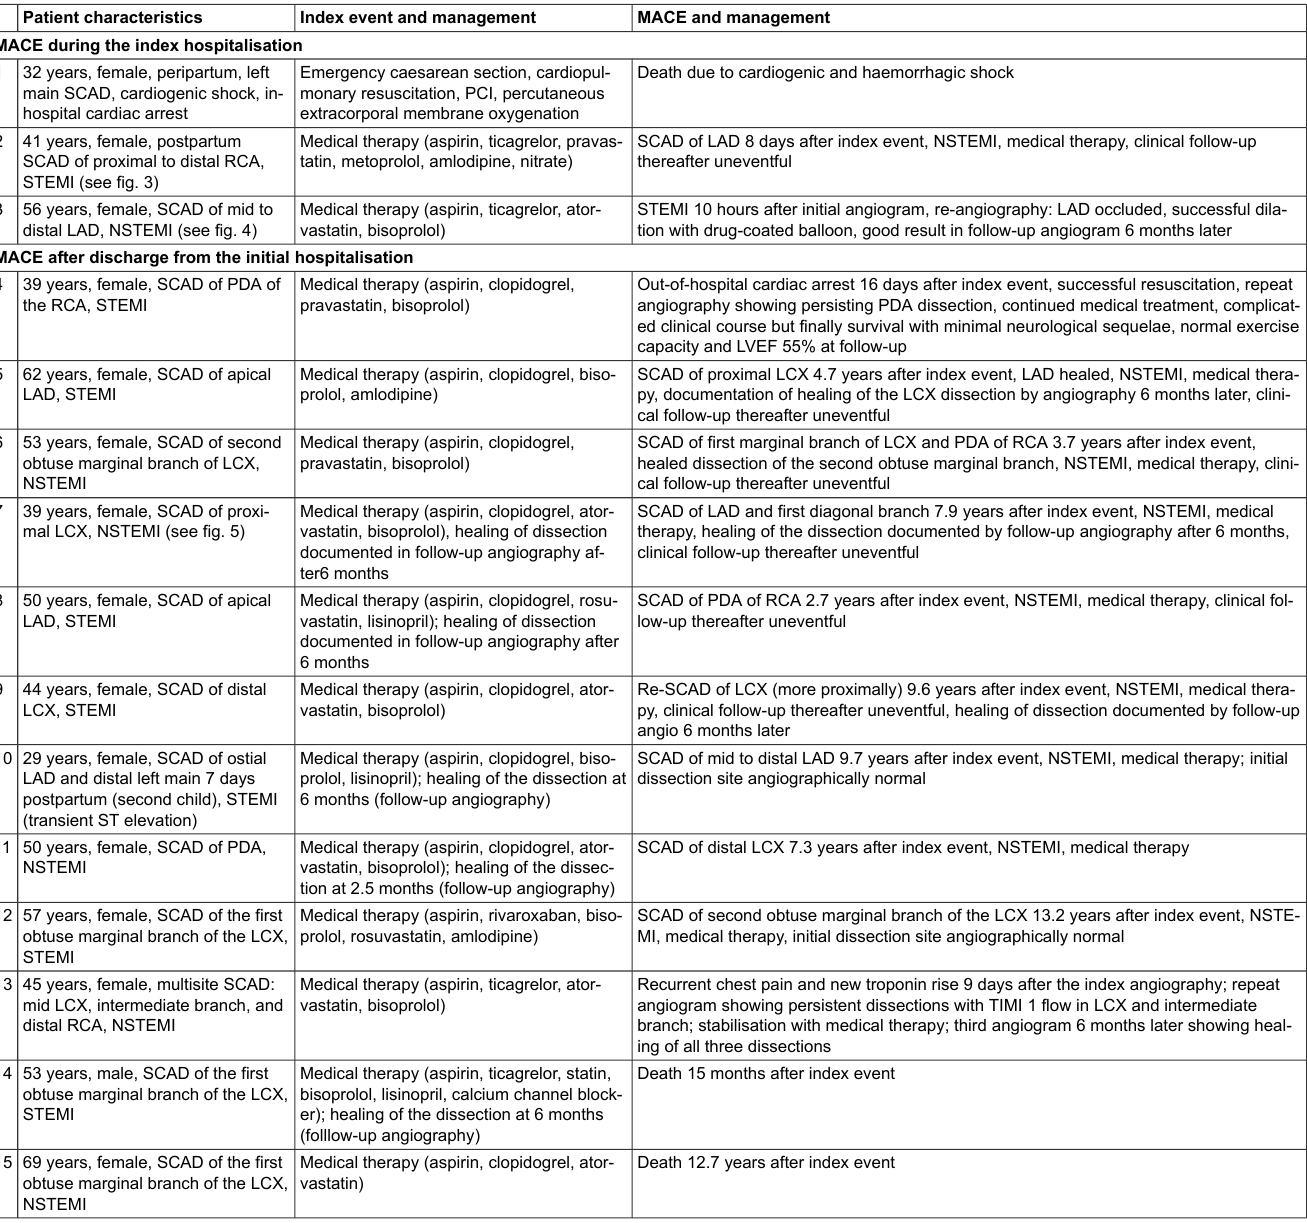
Table S1: Major cardiac events (MACE; please see also